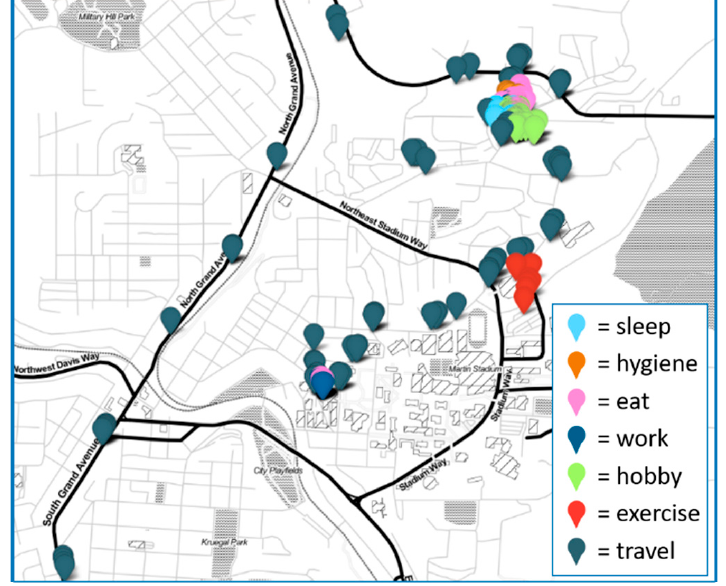
Figure 3. Map of locations visited over the course of a single day for one user with corresponding activity labels.